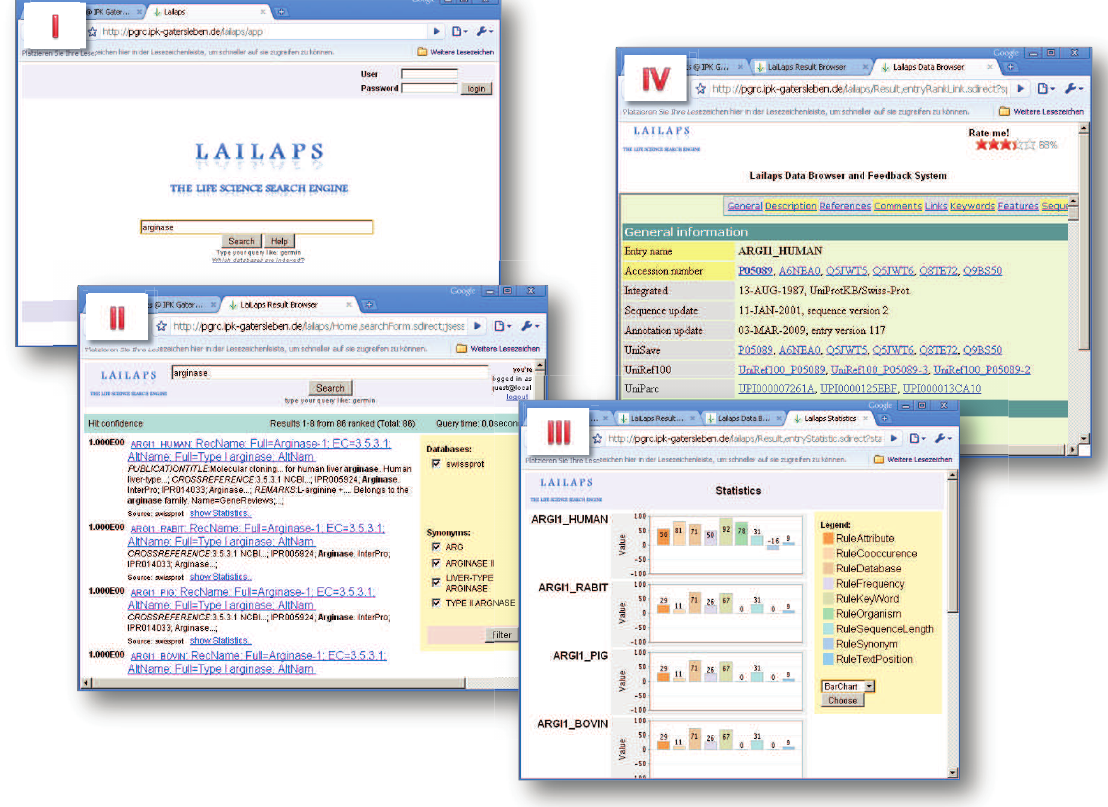
Figure 4: LAILAPS view of an example query session – The four browser windows represent the common query workflow of LAILAPS. Start screen with an optional login to load a customized ranking profile (I). The query might be specified as a single word, combination of words delimited by a whitespace or quoted phrases. The ranked query result is presented as a list of relevance sorted database accessions (II), with a short hit description, the evidence value, the hyper link to the original data source and a link to the scoring statistics in window (III). The exploration of hits is supported by a detail browser and feedback system (IV). The original data is extracted from the original source and displayed. The user have to be aware that LAILAPS is querying the original data from the SRS system, which installed at the EBI ( http://srs.ebi.ac.uk ). Thus, some outdated accession may result in broken links. In this page, the user might rank the relevance of the hit for later training of the user ranking